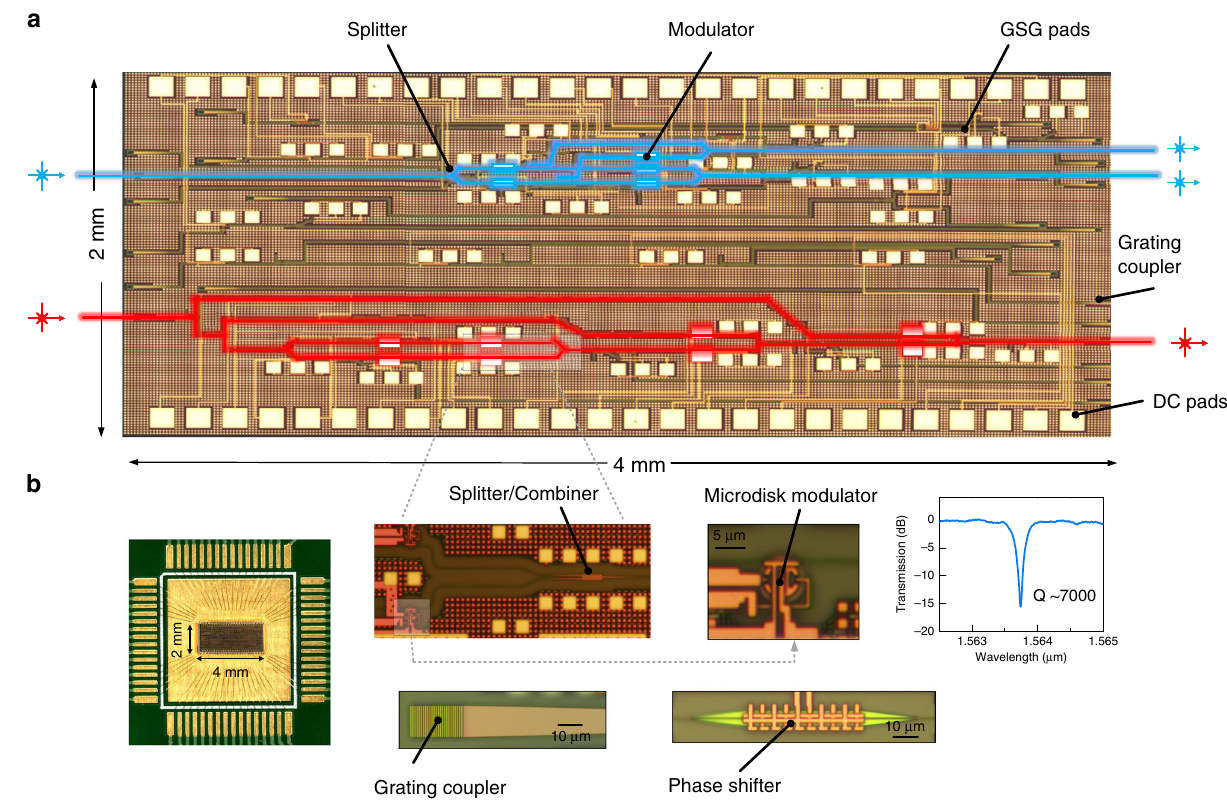
Fig. 2 Experimental demonstration. a Optical micrograph illustration of the fabricated two-bit (blue) and four-bit (red) OCPN. b Micrographs of the wire- bonded chip as well as close-ups of fundamental photonic components such as the phase shifter, the splitter/combiner, the grating coupler, the microdisk modulator, the photodetector, and the crossing. The spectrum of one peak of the microdisk is also